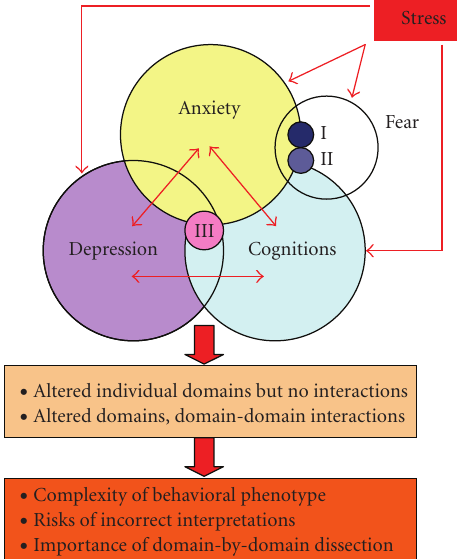
Figure 1: Interplay between fear, anxiety (including posttraumatic stress (I), and phobic disorders (II)), depression (including recur- rent depression associated with negative memories (III) and